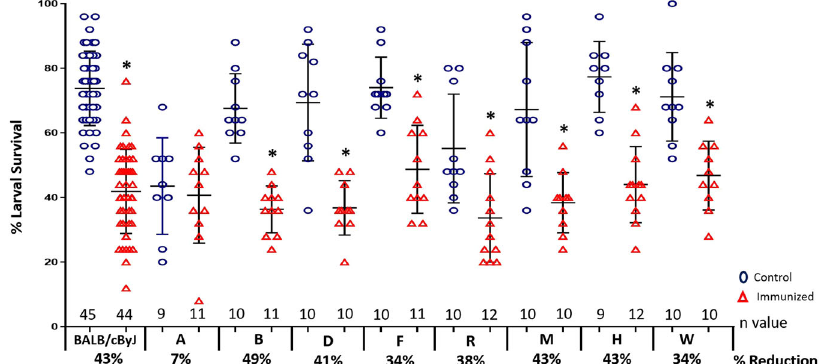
Fig. 1 Survival of larval Onchocerca volvulus in control and immunized CC-RIX and BALB/cByJ mice. Mice were vaccinated intramuscularly with Ov -103 and Ov -RAL-2 formulated with Advax-2 (red triangles) while the control mice received only Advax-2 (blue circles). Diffusion chambers containing challenge infections of 25 O. volvulus infective third-stage larvae were recovered one-week after implantation and larval survival was determined. Mean percent larval survival ± standard deviations are marked for each group. n values for each group are listed above each strain/line, while percent reduction in larval survival comparing vaccinated to controls is listed below each strain/line. *statistically signi fi cant, p ≤ 0.05, when comparing results from control mice to vaccinated mice within each